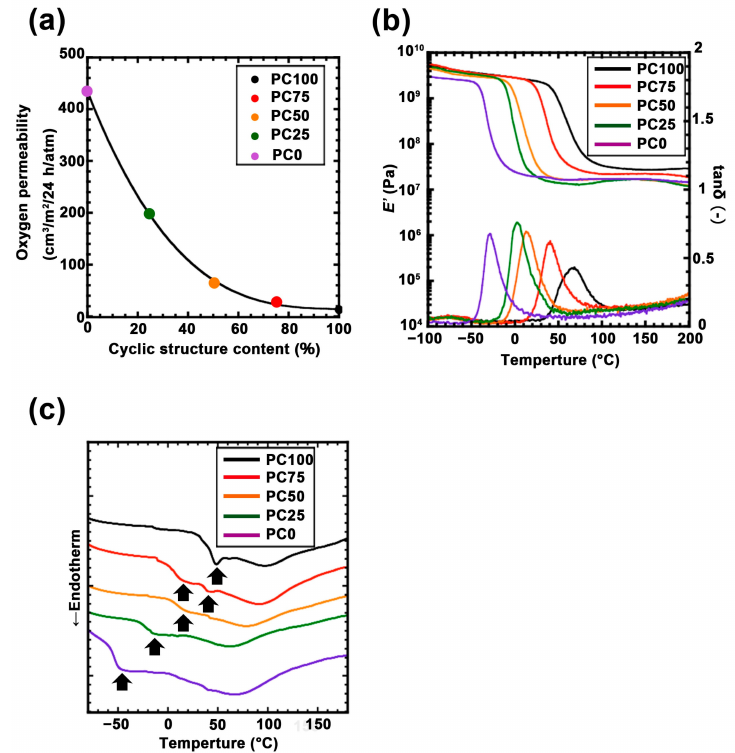
Figure 3. ( a ) Oxygen permeability test of each polycarbonate/titania hybrid film: PC100 (black dot), PC75 (red dot), PC50 (orange dot), PC25 (green dot) and PC0 (purple dot). ( b ) Dynamic thermomechanical analysis (DMA) curve for the polycarbonate/titania hy- brid film: PC100 (black line), PC75 (red line), PC50 (orange line), PC25 (green line), and PC0 (purple line). ( c ) Differential scanning calorimetry (DSC) curve for each polycar- bonate/titania hybrid film: PC100 (black line), PC75 (red line), PC50 (orange line), PC25 (green line), and PC0 (purple